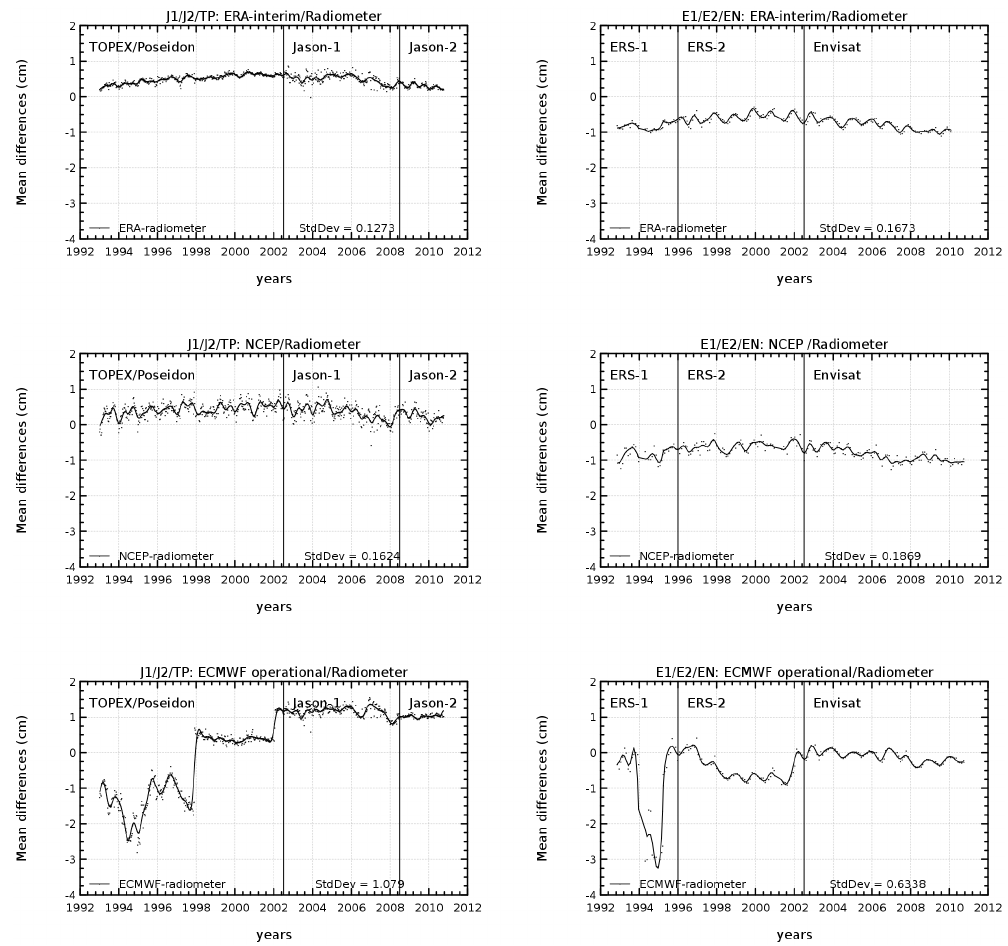
Figure 3. Temporal evolution of global mean differences between altimeter SSHs corrected from wet troposphere corrections computed with several models and the radiometers (in cm): ERA-Interim reanalysis (top), NCEP/NCAR reanalysis (middle) and ECMWF operational (bottom). Statistics have been computed with TOPEX/Jason-1/Jason-2 data on the left and ERS-1/ERS-2/Envisat on the right without any geographical selection of the data. The biases between the radiometer measurements of the altimeter missions have been removed.